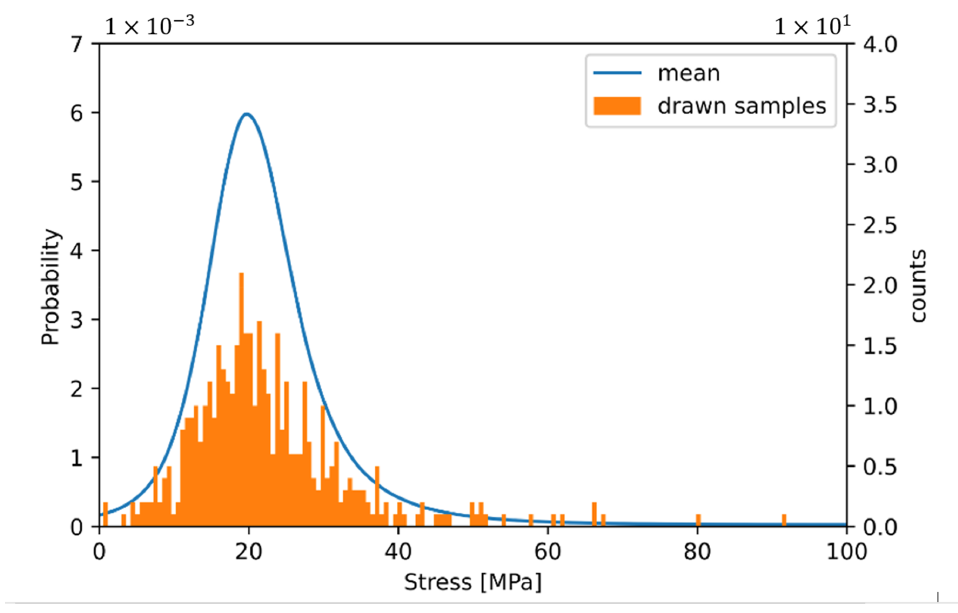
Figure 12. Average stress distribution and illustration of drawn samples.